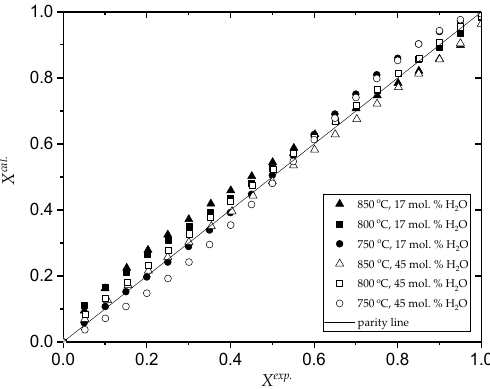
Figure 8. Plots for the VM rate equation.